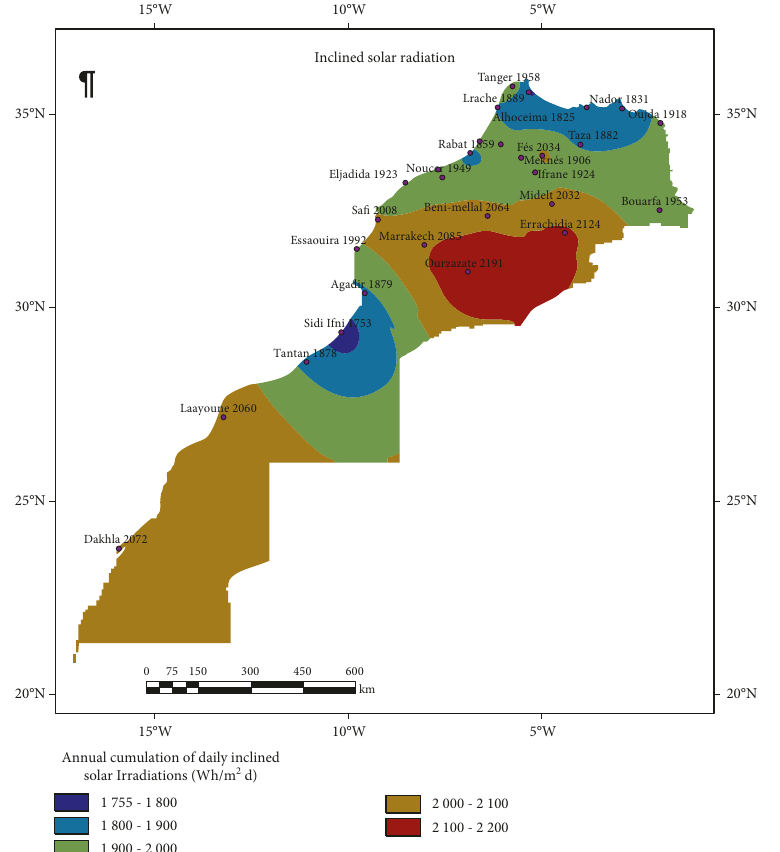
Figure 12: Map of annual cumulation of daily global irradiations on inclined planes ( β = the site latitude) incident in the Moroccan territory. Map of the global solar radiation inclined with β = the latitude ’ s